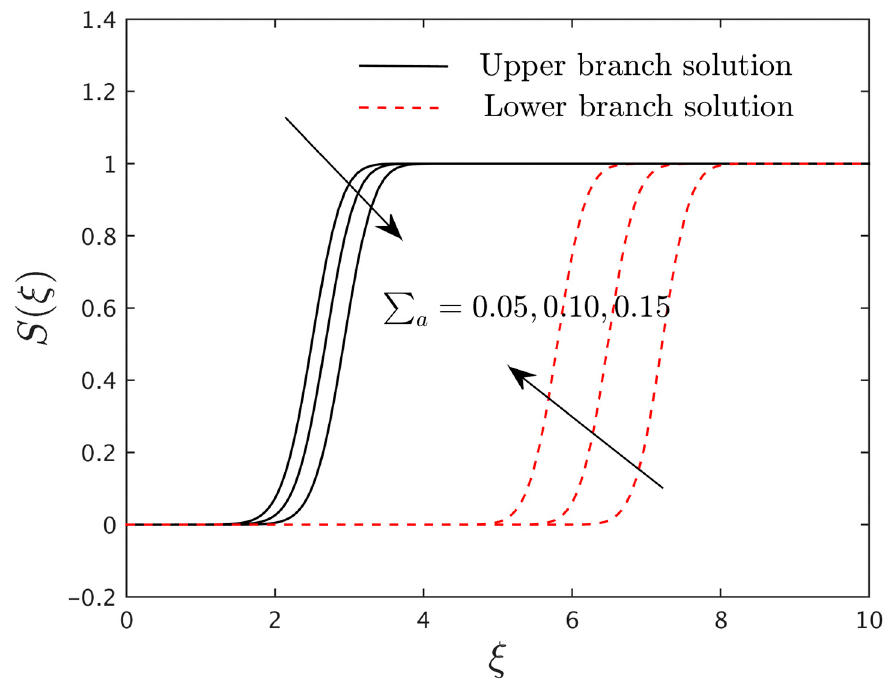
Figure 14. The concentration profiles S ( ξ ) for the numerous values of Σ a when Pr a = 1.0, Sc a = 10.0, Pr = 6.2, ϕ = 0.025, and γ s =